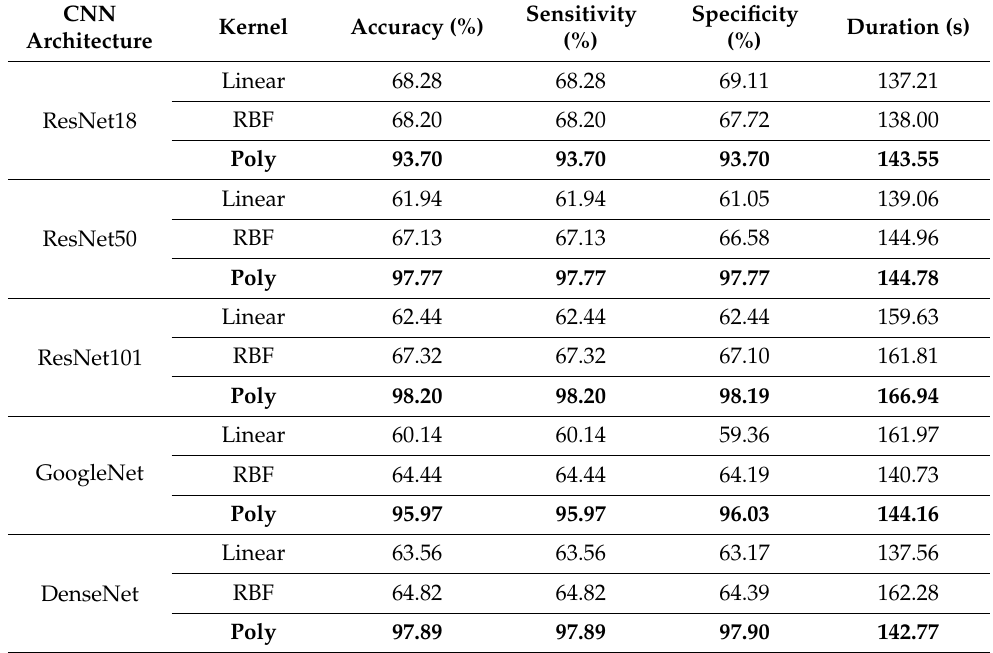
Table 5. Results of Experiment on 4 Class MESSIDOR Dataset. Table 2. Results of Experiment on Two-Class DRIVE Dataset.